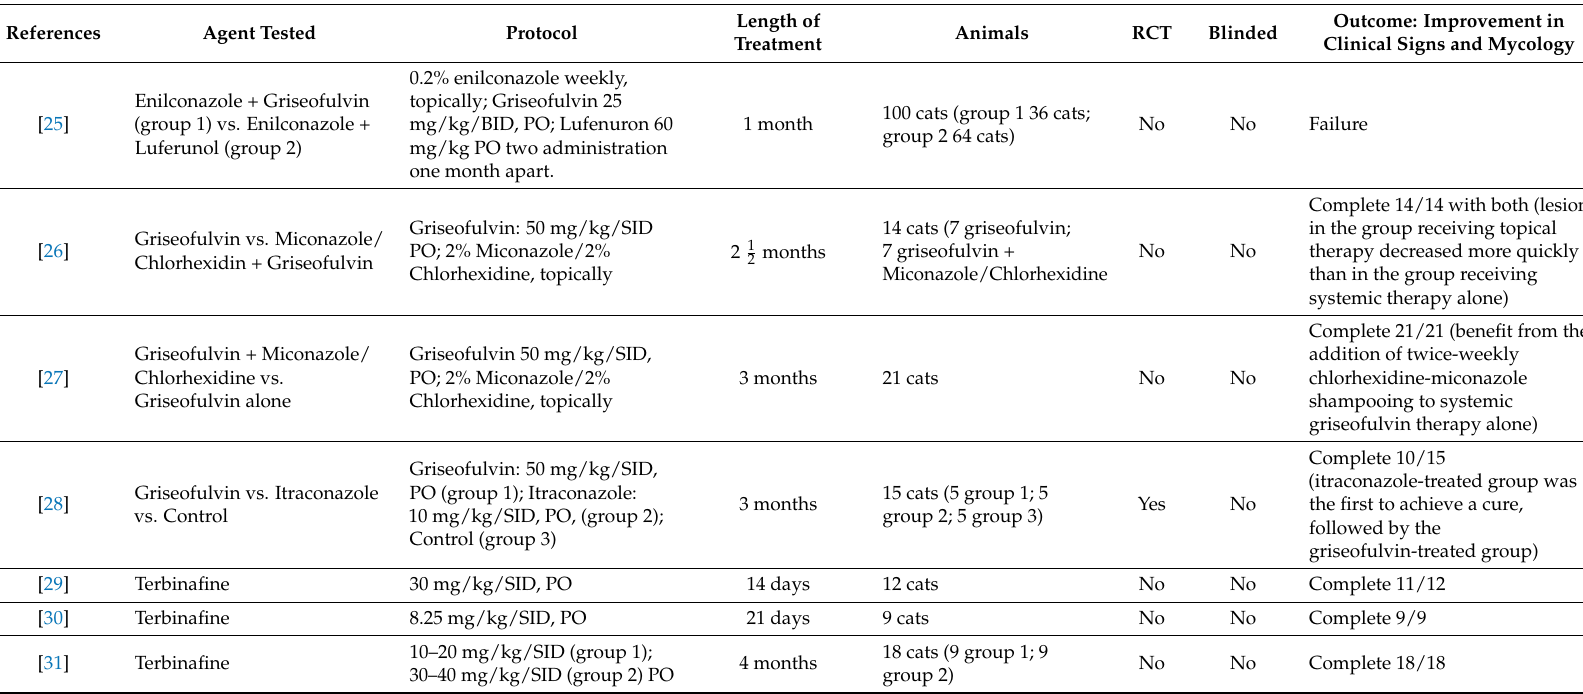
Table 1. In vivo prospective studies on the topical and systemic treatment of animal dermatophytosis reporting clinical and/or mycological